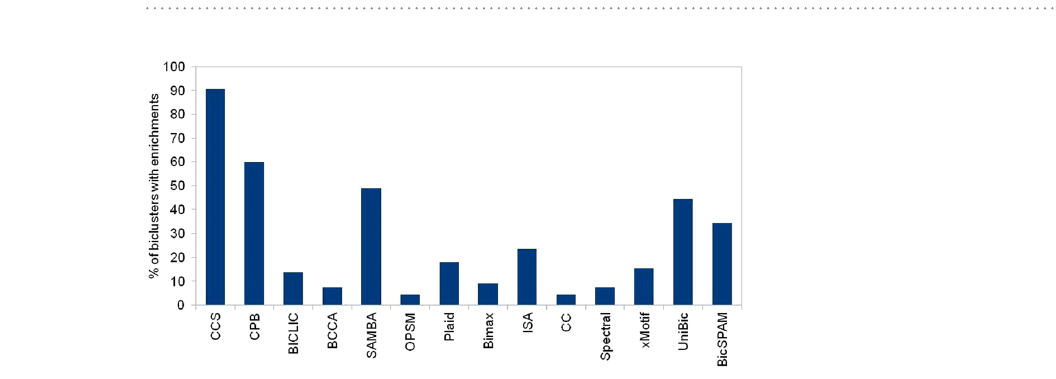
Figure 2. Average number of enriched terms on five gene expression datasets. All the enriched gene ontology terms with Benjamini-Hochberg FDR less than 0.01 were considered.